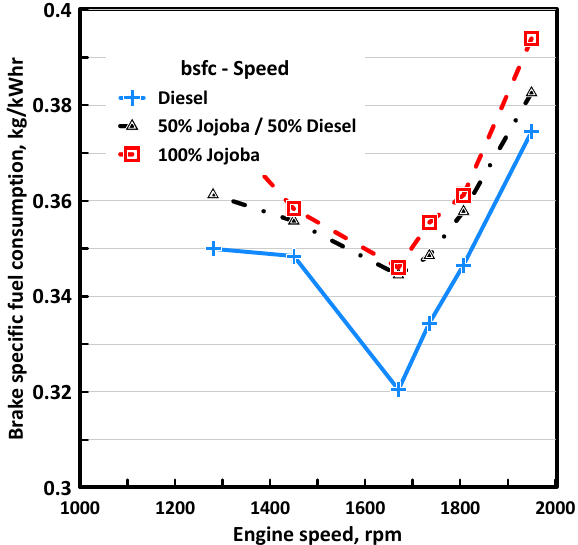
Figure 4. Brake power output versus engine speed for diesel fuel and raw Jojoba oil.